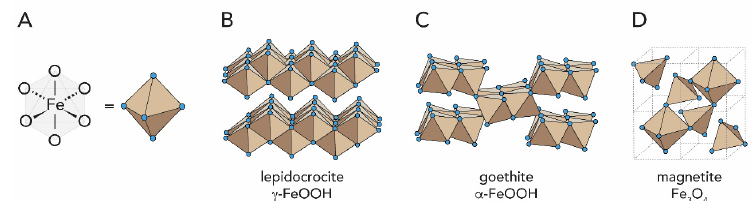
Figure 4. Examples of crystalline forms of iron oxides in living nature. ( A ) Octahedral geometry of iron. ( B ) Lepidocrocite, ( C ) goethite and ( D ) spinel structure of magnetite. For clarity, only oxygen is shown (blue sphere), while iron (not shown) is at the center of the polyhedral.